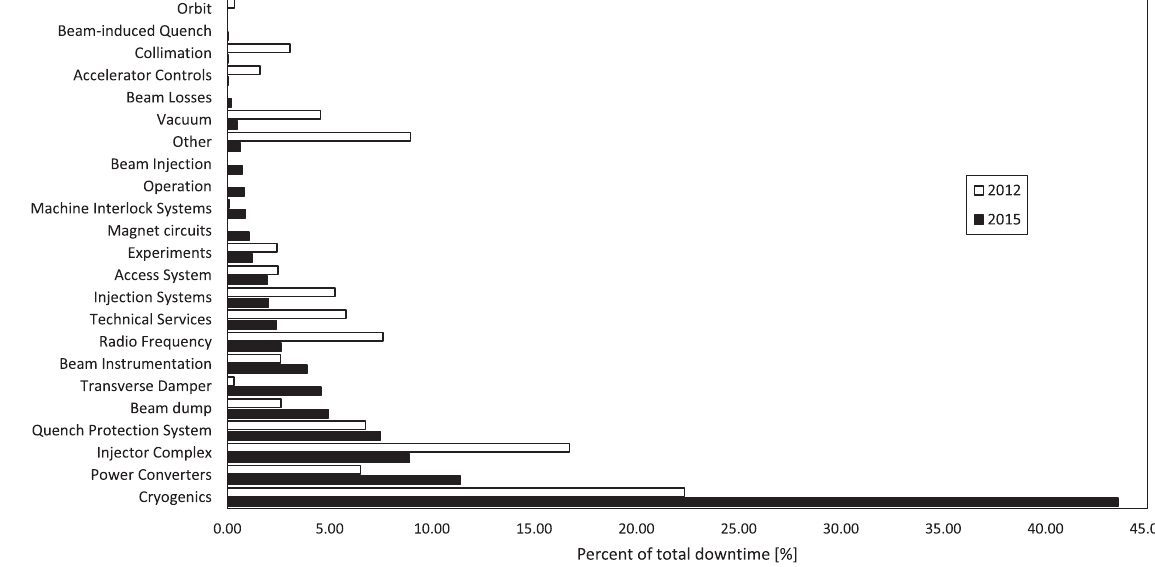
FIG. 7. LHC system downtime for 2012 and 2015 based on data from